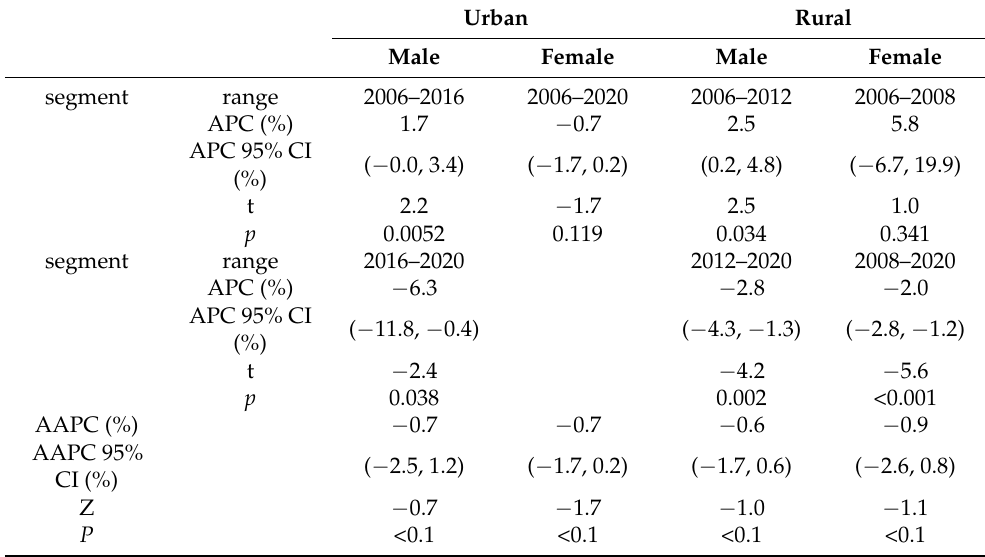
Table 1. Changes in crude mortality rates of injury and poisoning by gender and region.